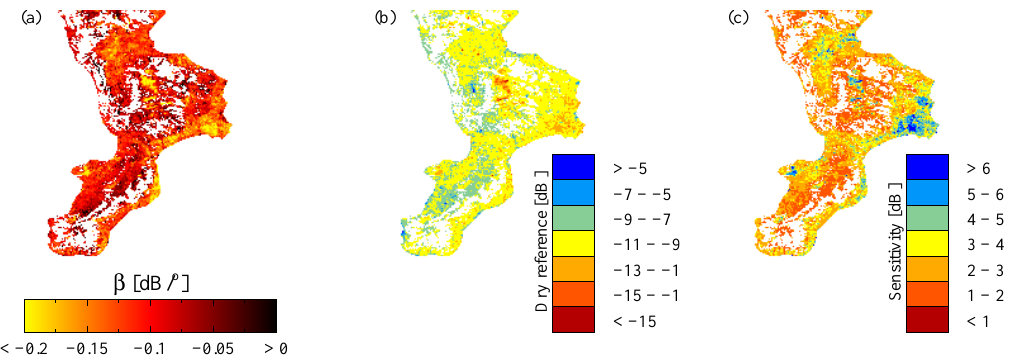
Fig. 4. Angular correction coefficient β for each pixel in the study site (a) ; dry reference backscatter (b) ; sensitivity of the backscatter to soil moisture changes, derived as the difference between dry reference and wet reference backscatter (c)